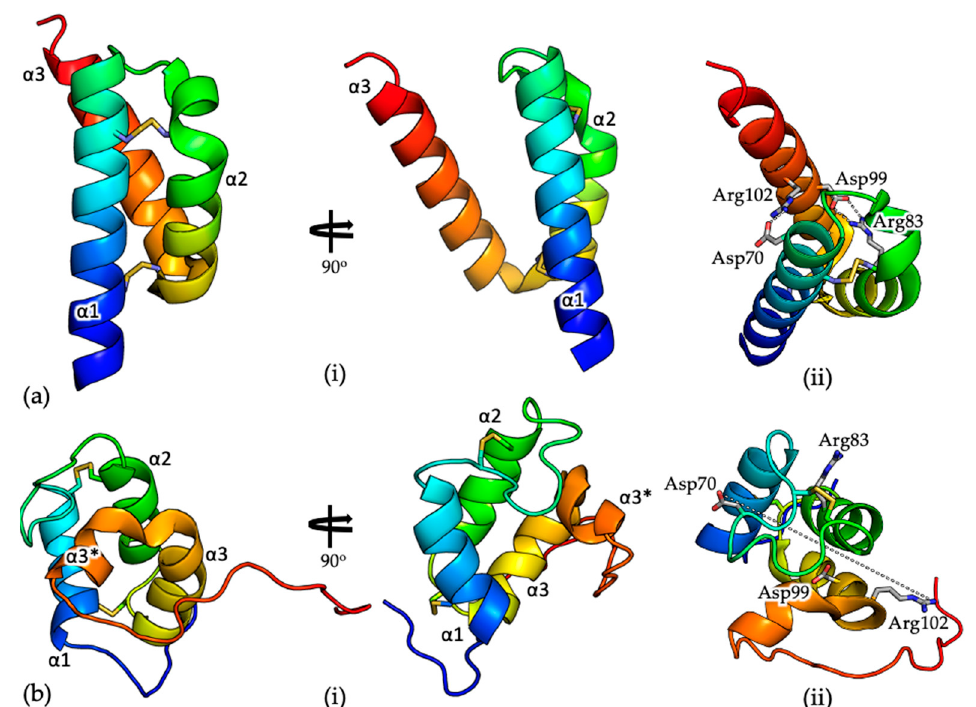
Figure 2. ( a ) Cartoon representation of the crystal structure of COA6 (PDB 6PCE) [56]. (i) The structures are colored from blue at the N-terminus to red at the C-terminus. Cysteine residues are shown as yellow sticks; (ii) Salt bridges between residues Arg83 ( α 2) and Asp99 ( α 3) and residues Asp70 ( α 1) and Arg102 ( α 3), which stabilize the relative orientations of these secondary structural elements, are indicated as dashed lines; ( b ) Cartoon representation of the solution structure of COA6 (PDB 6NL3) [52] (i) The structures are colored from blue at the N-terminus to red at the C-terminus. Cysteine residues are shown as yellow sticks; (ii) Residues Arg83 ( α 2) and Asp99 ( α 3) and residues Asp70 ( α 1) and Arg102 ( α 3) (labeled), which form salt bridges in the crystal structure, are located on ‘opposite’ sides of the molecule and separated by ~25 Å.